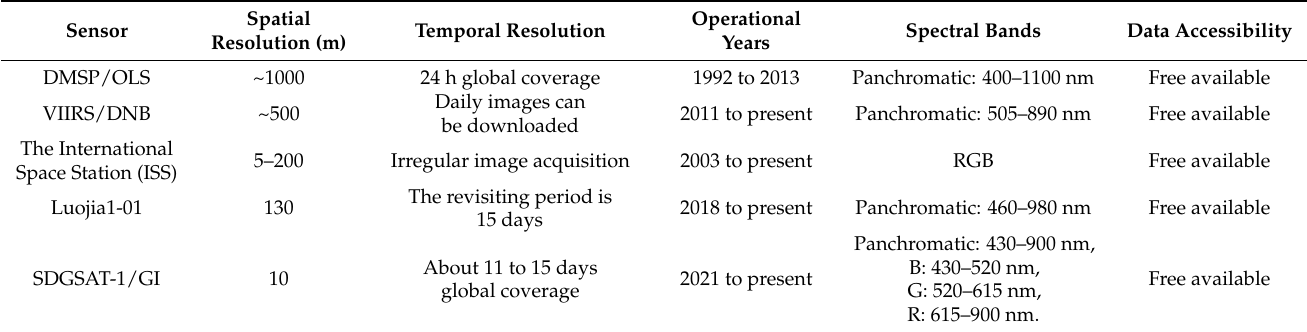
Table 1. Comparison of GI NTL data with other available data.